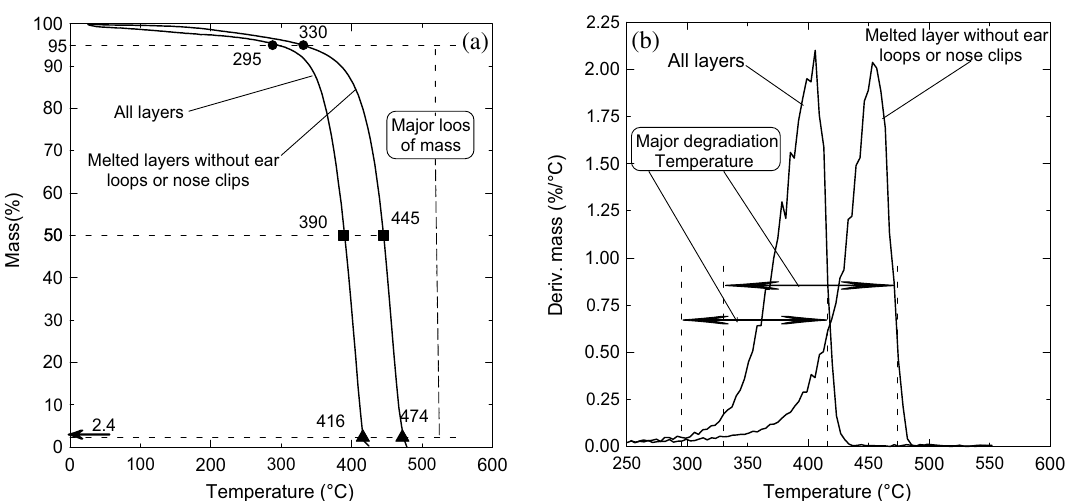
Figure 15. Thermal stability analysis of the three layer fibers and composite melted sample number 7 showing the important degradation and decomposition points, ( a ) thermogravimetric analysis (TGA) and ( b ) derivative thermogravimetric analysis